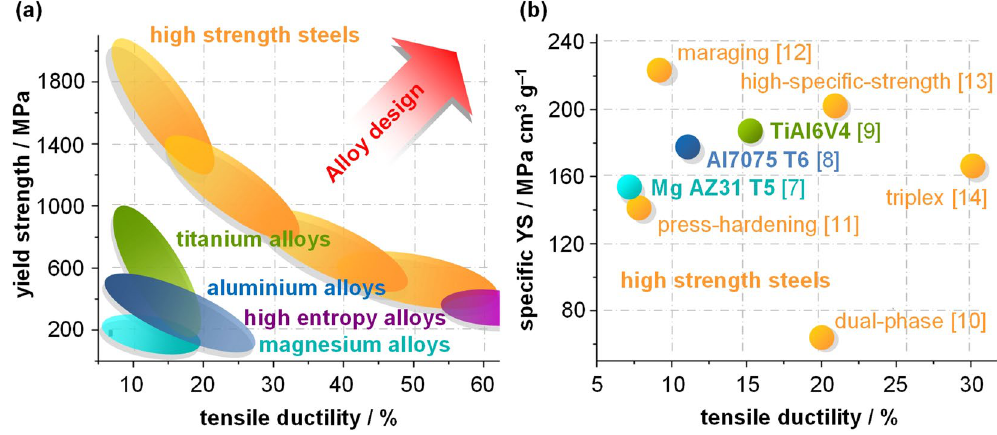
Figure 1. Established Ashby-type diagrams for lightweight material design: ( a ) Areas of YS vs. TE for different material systems 2–6 . ( b ) YS per ρ vs. TE of the highest performing alloys of each material system 7–14